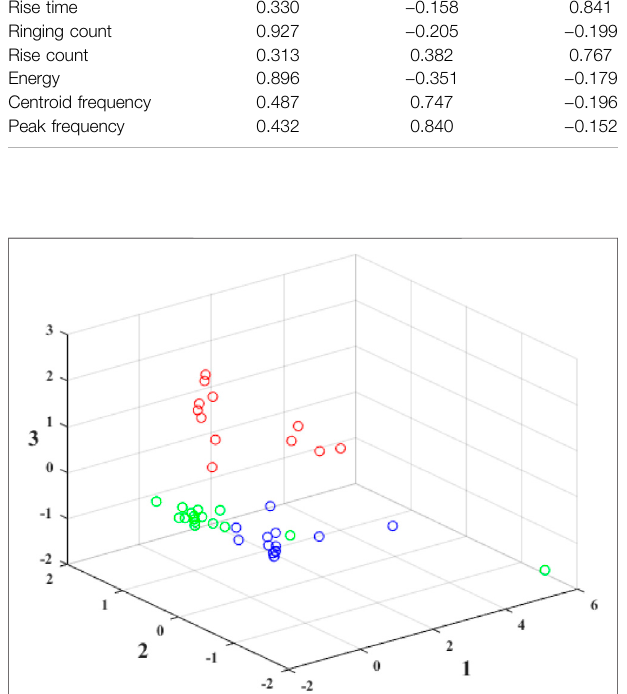
FIGURE 8 | FCM clustering diagram of PCA results.